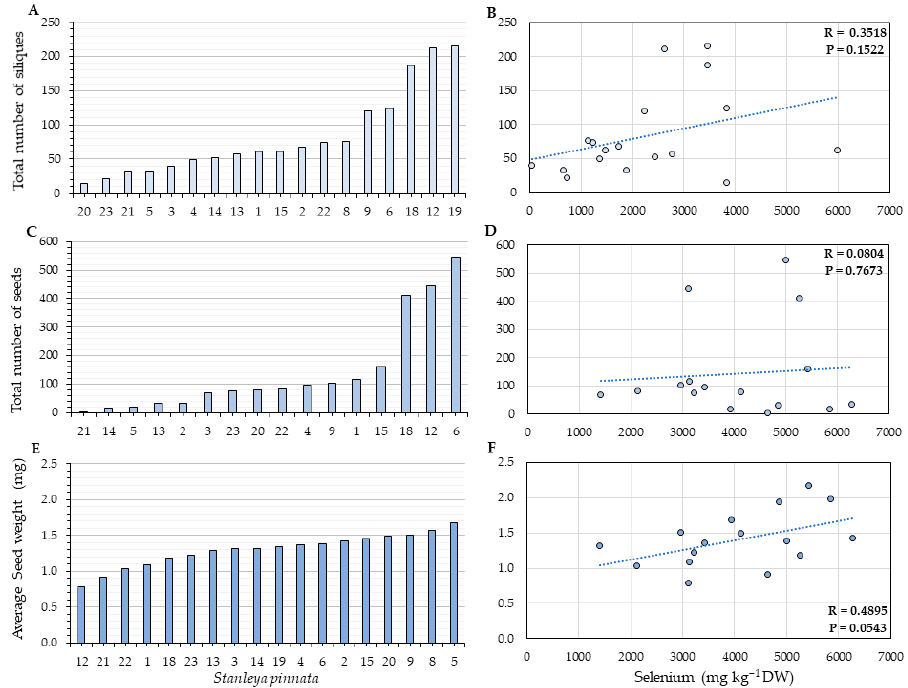
Figure 6. Reproductive fitness parameters ( A , C , E ) and their correlation with silique ( B ) or seed ( D , F ) Se concentration for S. pinnata plants growing at Coyote Ridge. ( A , B ) Total number of siliques per plant, ( C , D ) total number of seeds per plant, and ( E , F ) average seed weight. The numbers on the horizontal axis ( A , C , E ) represent the collection numbers of individual plants at the locations indicated in Figure 2. The graphs show the correlation coefficient R and p -value for panels ( B , D , F ).